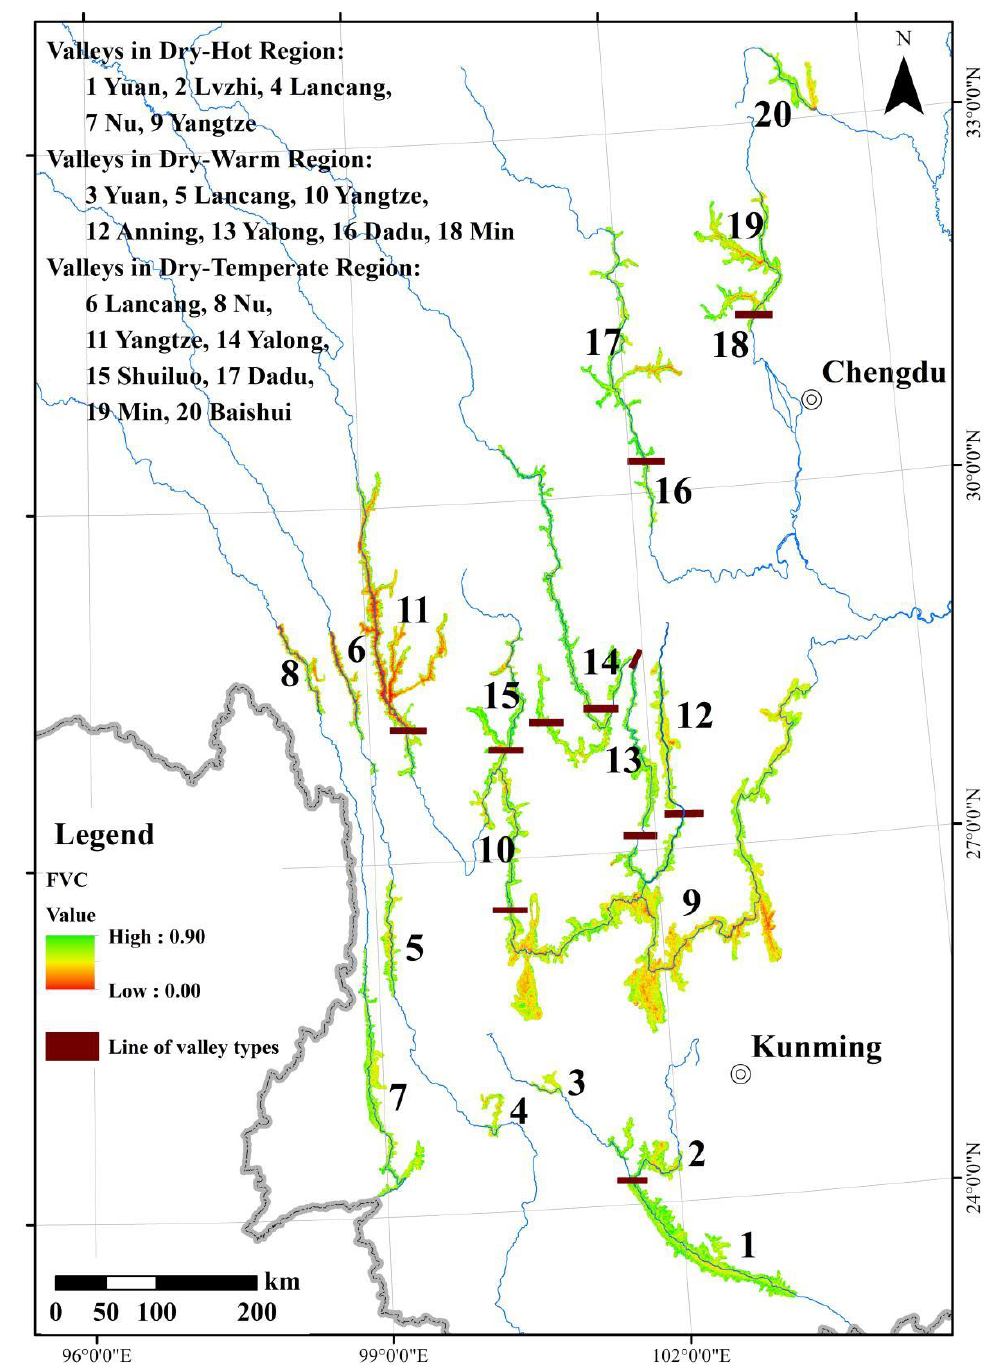
Figure 3. Spatial distribution of long-term annual FVC in dry valleys of Southwest China. The dry valleys with a high grade were the dry–warm and dry–temperate valleys in the Yangtze River and its tributaries, together with the dry–warm valley in the Lancang River and the dry–hot valley in the Nu River. The average annual FVC of these 11 valleys ranged from 0.495 to 0.574, with an area-weighted average value of 0.526 (Table 4; Figure 3). The relatively high FVC values in these valleys were attributed to the following: (1) the warm and temperate climate conditions with less evaporation and low elevation (Table 2)